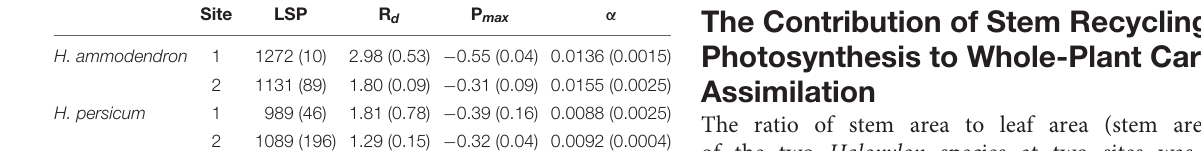
TABLE 1 | Stem light response parameters for two Haloxylon species growing under different groundwater depths. Site LSP R d P max α